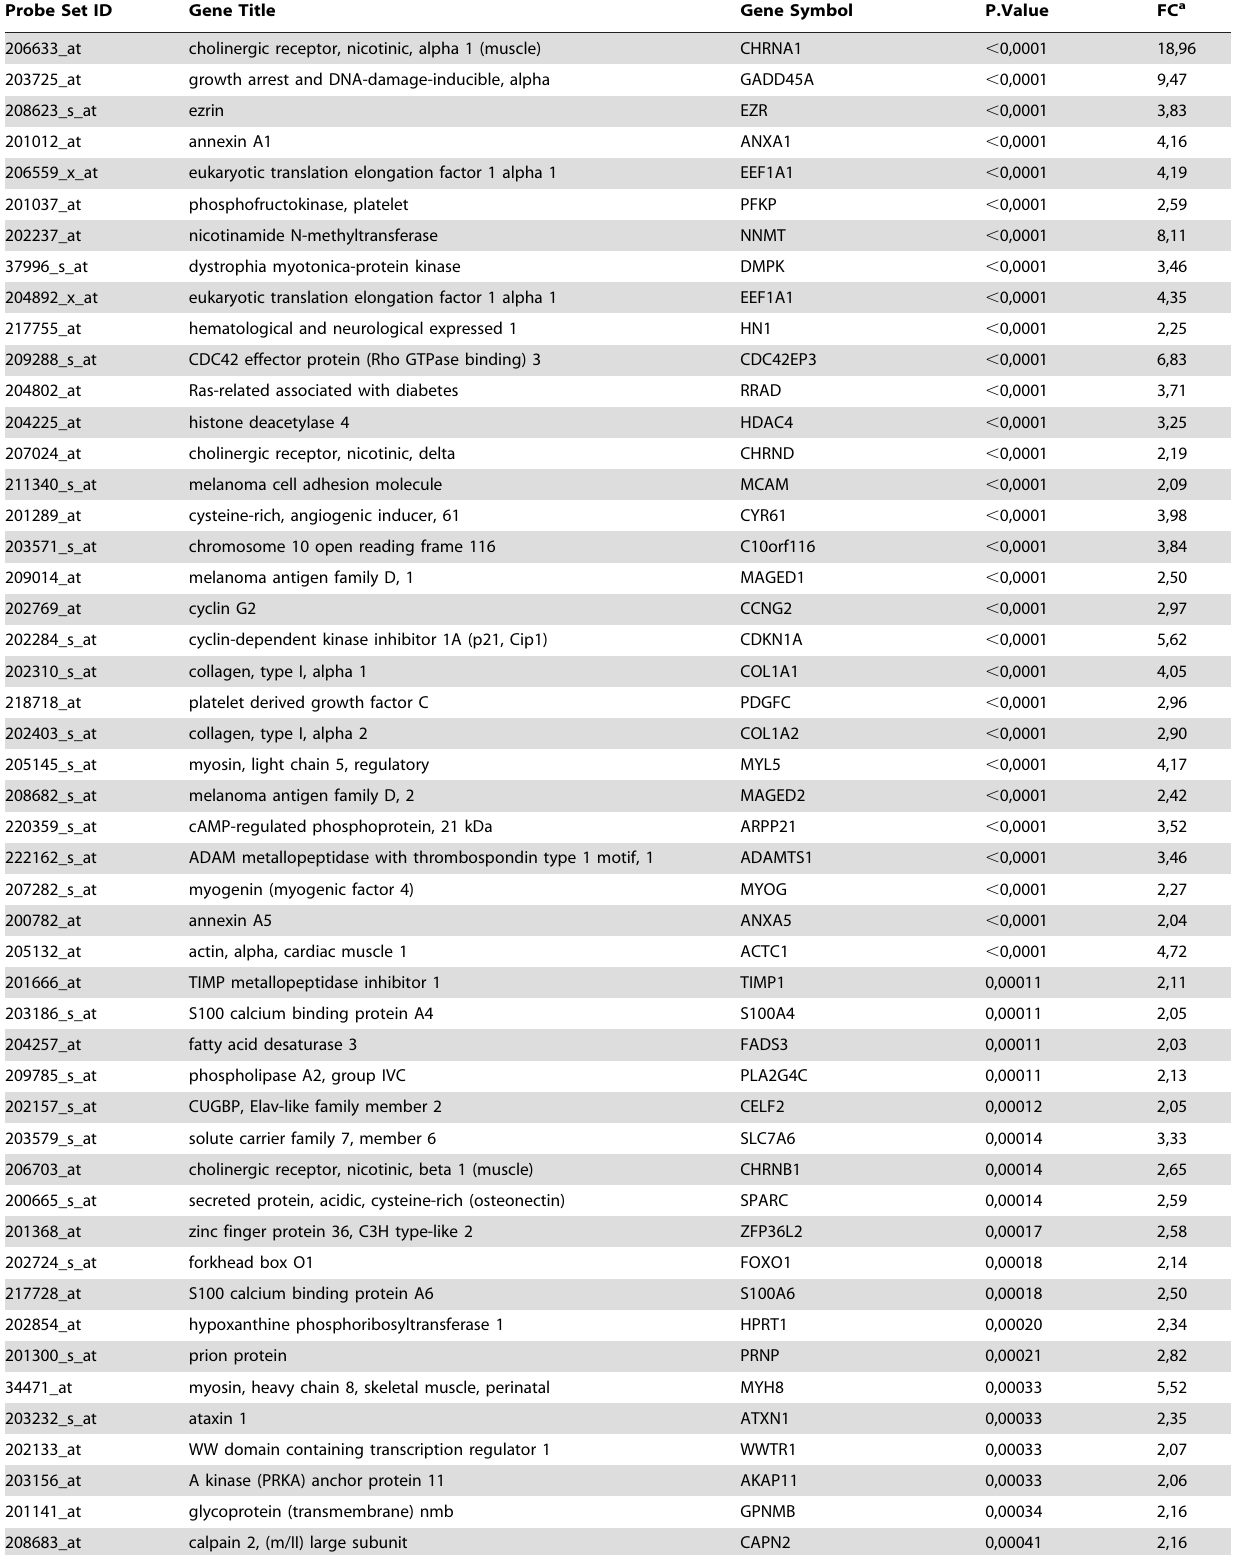
Table 2. Differentially expressed genes